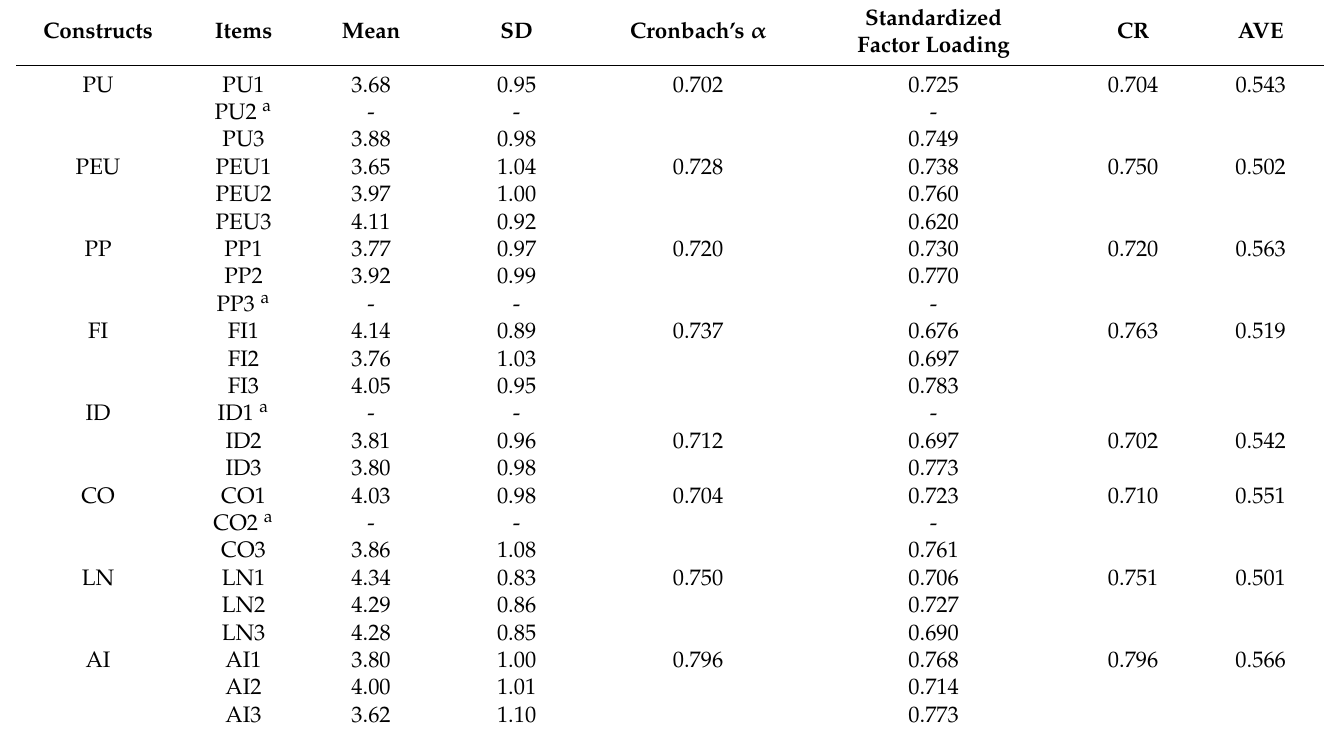
Table 2. Reliability and validity tests of the constructs.